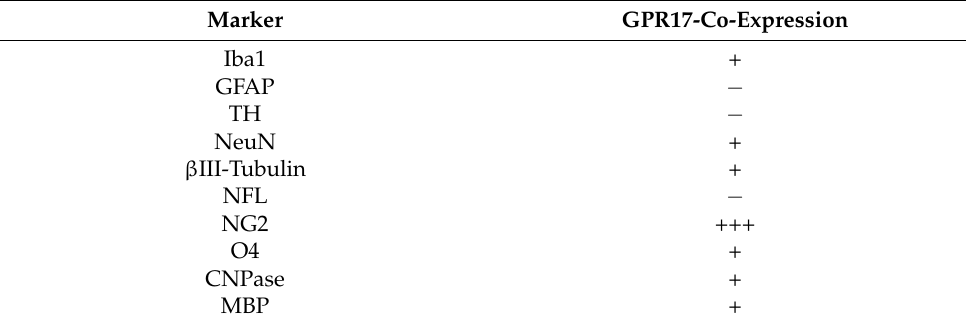
Table 2. Expression of GPR17 in organotypic slice